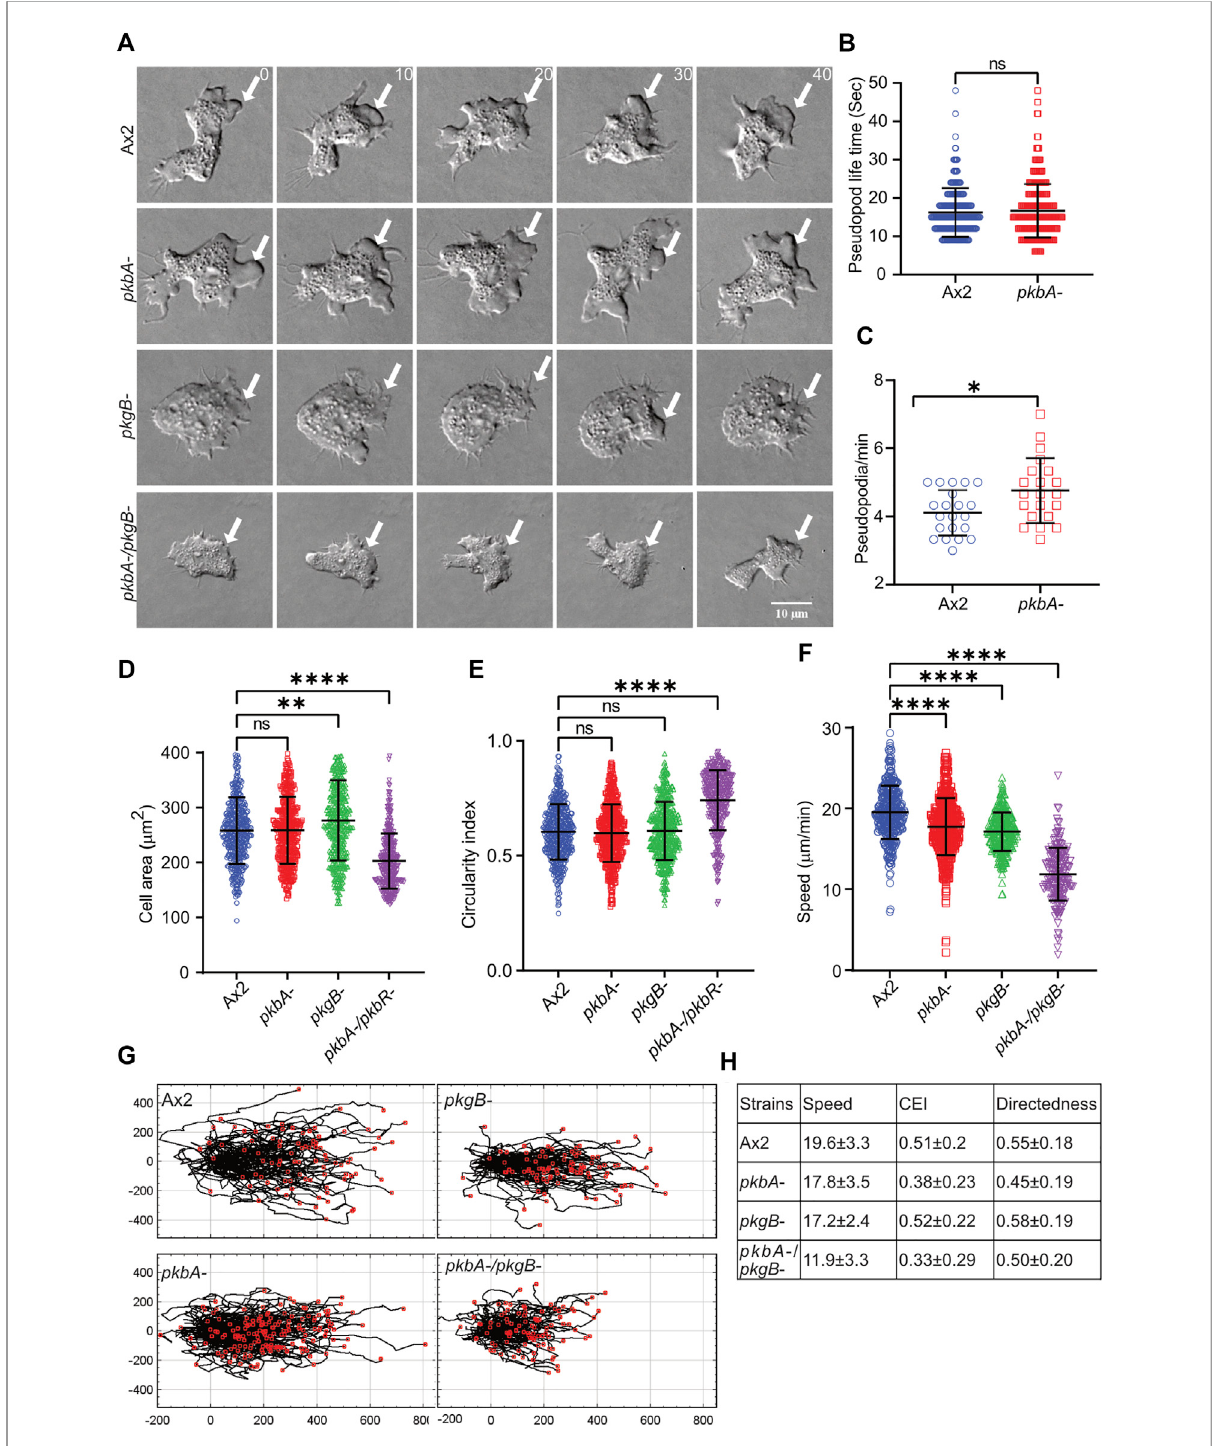
FIGURE 2 pkgB isrequiredforef fi cientpseudopodiaformationandcellmigration. (A) Representativeimagesof > 20cellsshowingpseudopodiaformation inAx2andmutantcells. Ax2, pkbA- , pkgB- and pkbA-/pkgB- cells wereallowed tomigrate underagarosesensing afolate gradient andwereimaged by DIC microscopy at a frame interval of 2 s (1f/2 s). Pseudopods are formed in Ax2 and single mutant pkbA- , but not in pkgB- and double mutant pkbA -/pkgB-(arrows). (B – C) Effectof pkbA- onpseudopodsdynamics.PseudopodlifetimeandgenerationratewasmeasuredfromDICvideos usingImageJfromsingleframes,andgenerationratecalculatedfromthenumberofpseudopodslastingatleast2frames.Lifetimeofpseudopodiais equal in both Ax2 and pkbA- cells, but pkbA- generates pseudopods more frequently. (Mean ± SD, n > 20 cells, n > 25 cells from 3 experiments; * p ≤